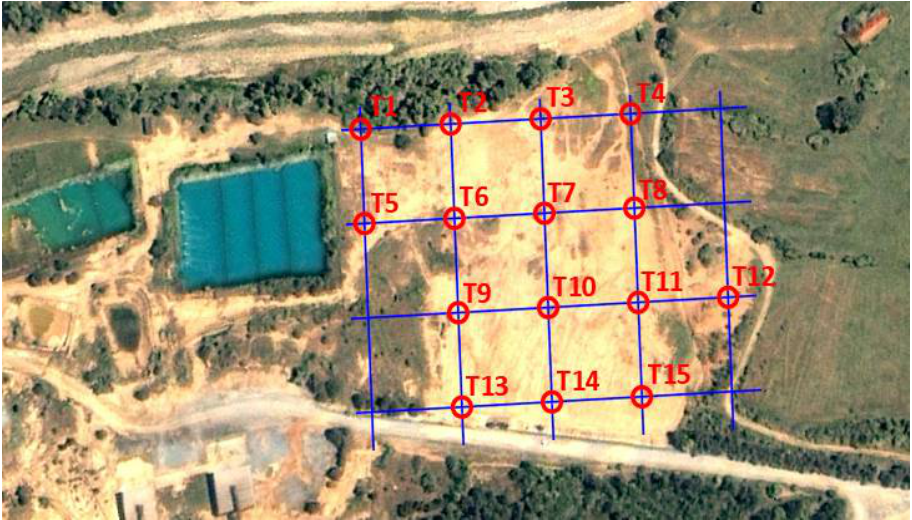
Figure 2. Old arsenopyrites concentrate storage area (former METBA plot).